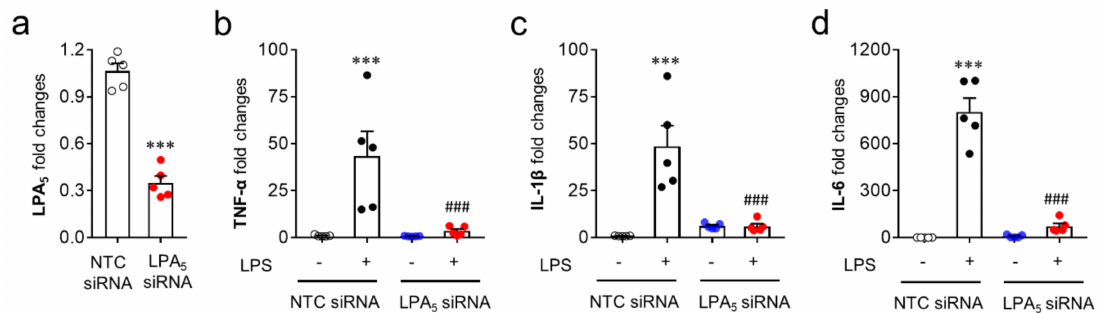
Figure 8. LPA 5 knockdown attenuates mRNA expression levels of pro-inflammatory cytokines in LPS-stimulated BV2 microglia. Transfected BV2 microglia with non-target control (NTC siRNA) or LPA 5 siRNA were stimulated with LPS (100 ng / mL) for 24 h and mRNA expression levels of LPA 5 or pro-inflammatory cytokines (TNF- α , IL-1 β , and IL-6) were then determined by qRT-PCR analysis. ( a ) Knockdown e ffi ciency for LPA 5 . n = 5 per group. *** p < 0.001 versus cells transfected with